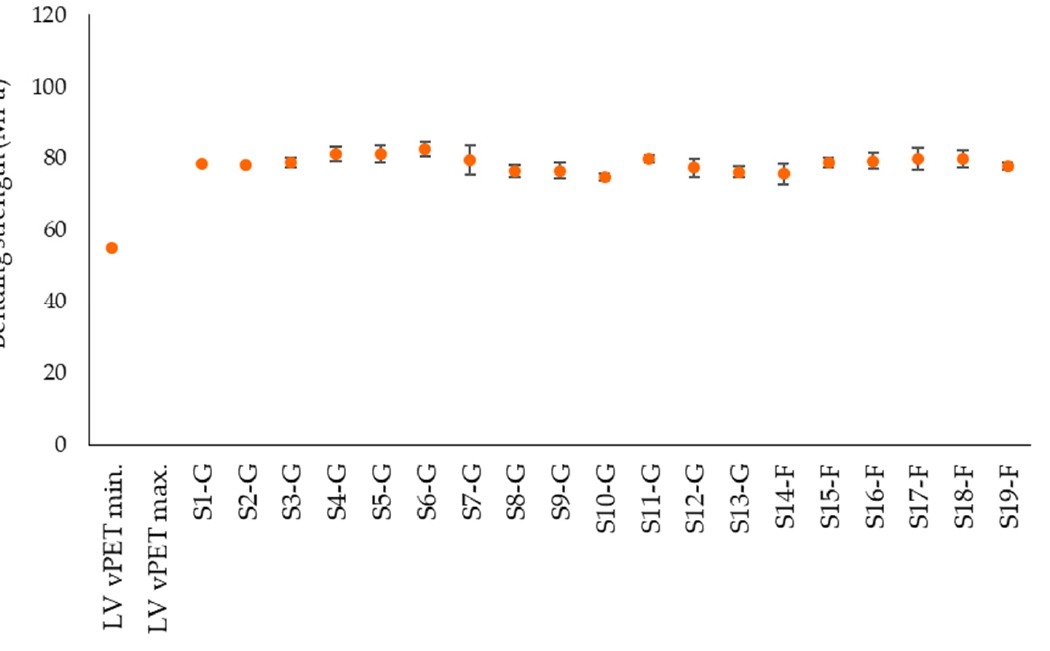
Figure 9. Experimentally determined elongation at flexural strength of rPET samples in comparison with literature values for vPET. 3.4. Impact Strength Finally, Figure 10 represents the impact strength results of tested samples compared to literature values. A slight difference between the values of industrial regranulates and laboratory-regranulated flake samples can be observed. The commercial regranulates have an average value of 1.9 kJ/m 2 in the range of 1.3–2.8 kJ/m 2 . This is comparable with the values for vPET in the range of 2–3 kJ/m 2 . In contrast, the regranulated flake samples are at an impact strength of 1.3–1.9 kJ/m 2 , with an average of 1.6 kJ/m 2 . The greater the impact energy consumed, the tougher the material. Accordingly, the industrial regranu- lates behave tougher in relation to the flake samples granulated in the laboratory.